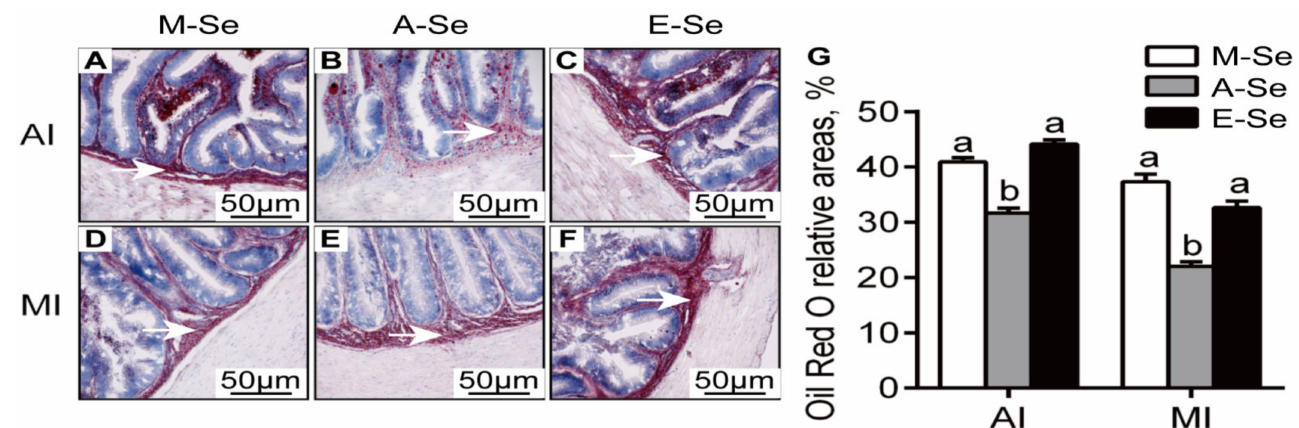
Figure 2. Effects of dietary Se supplementation on the histochemistry (Oil Red O staining, original magnification 200 × ) of anterior intestine (AI) ( A – C ) and middle intestine (MI) ( D – F ) in yellow catfish. Relative areas for lipid droplets in Oil Red O staining ( G ). White arrows point to red dot (lipid droplet). Values are mean ± SEM, n = 3 (replicates of 3 fish). Labeled means without a common letter differ, p < 0.05 (one-factor ANOVA, Duncan post hoc